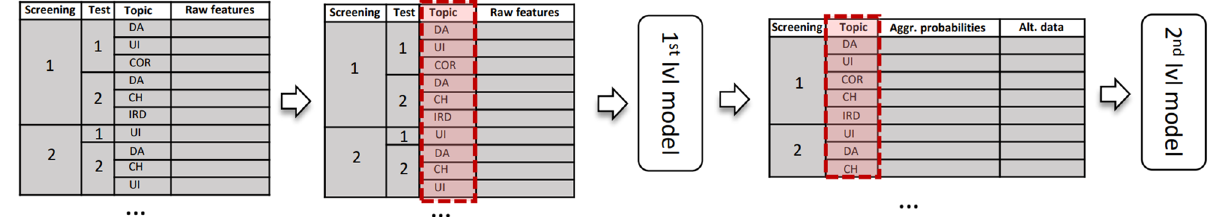
Figure 3. Universal model scheme. Information that is not received by the model is marked red.